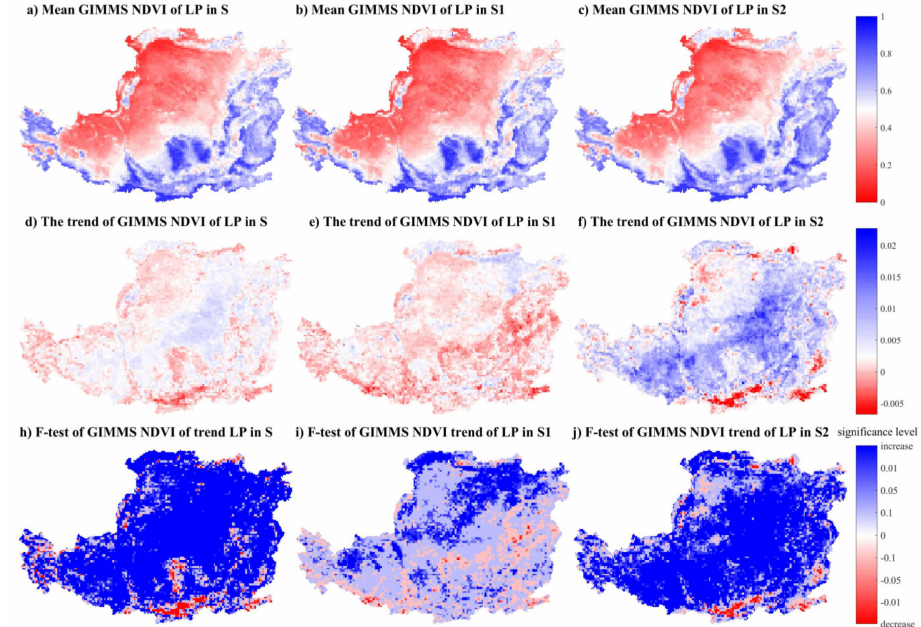
Figure 2. The ( a – c ) are average values, ( d – f ) are linear trends (unit: year-1), and ( h – j ) ars F-tests of the GIMMS NDVI for three periods, where S, S1, and S2 represent the periods of 1982–2015, 1982–1999, and 2000–2015,